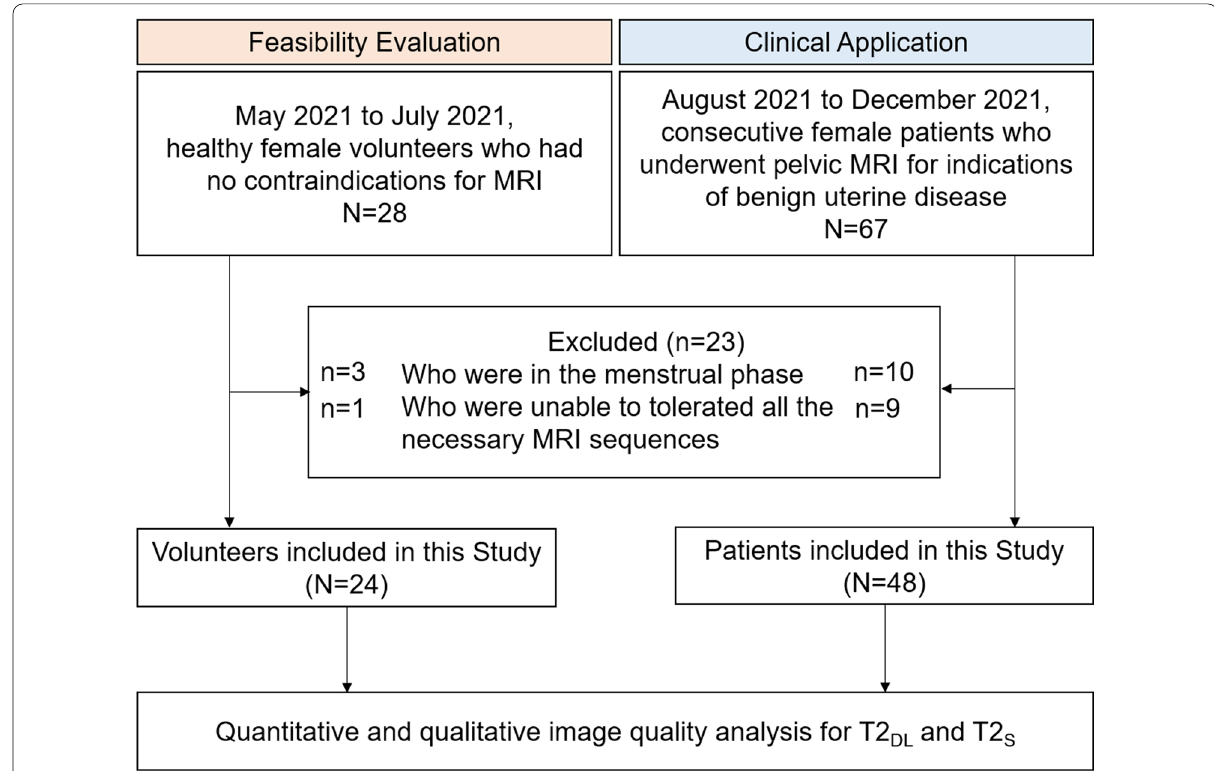
Fig. 1 Flowchart of volunteer and patient inclusion process. T2 DL , deep learning - accelerated T2‑weighted turbo spin echo sequence; T2 S , standard T2‑weighted turbo spin echo sequence